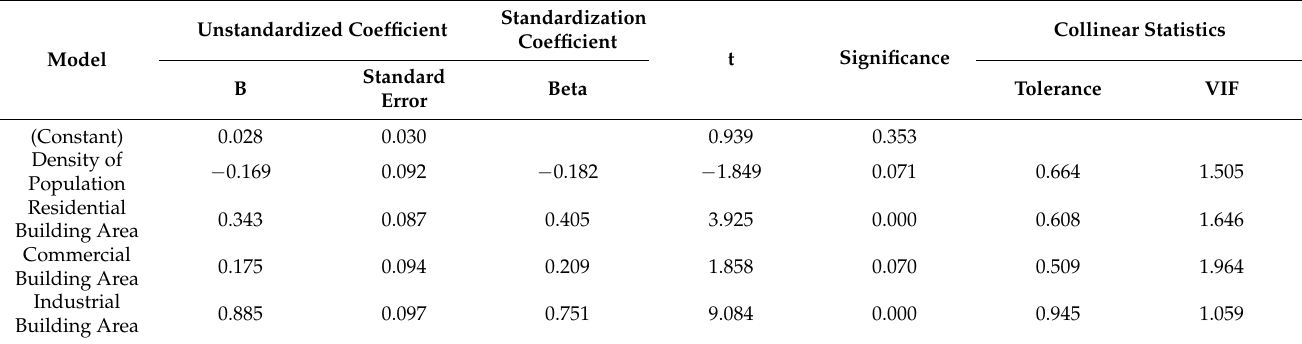
Table 6. Regression results of landscape spatial form and carbon emission in urban clusters .